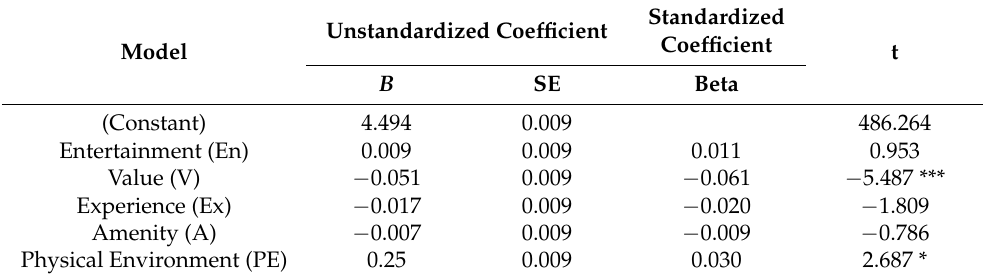
Table 9. Results of linear regression analysis (The Venetian in